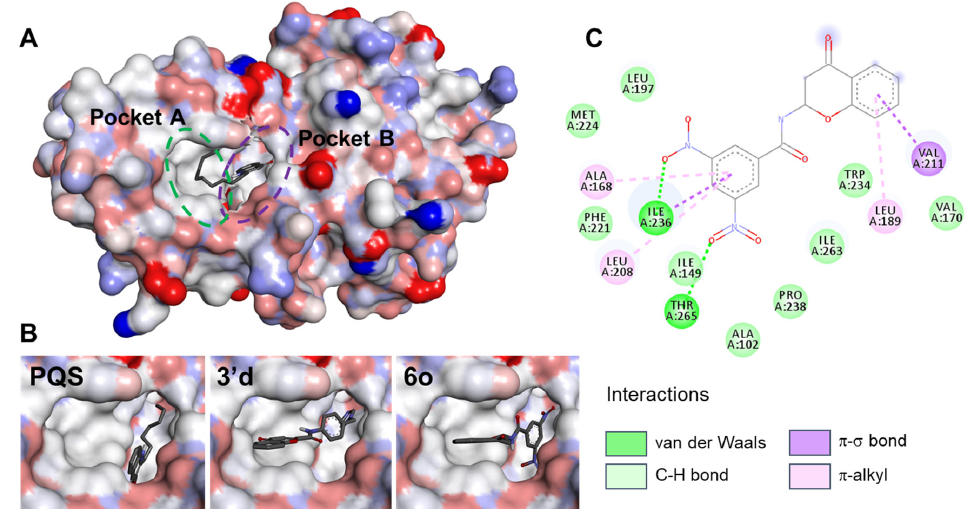
Figure 3. ( A ) PqsR-CBD structure (PDB code 4JVC) binding with NHQ [25]. PqsR solvent surface colored by atom charge (blue = positive charge, red = negative charge). ( B ) PqsR ligand binding site with PQS, compounds 3 ′ d and 6o . ( C ) 2D interactions diagram of compound 3 ′ d . Docking simulations were carried out with the apo form of the PqsR-CBD (PDB code: 4JVC [25]) by keeping all protein residues rigid, except for Ile149, Leu189, Ile236, Tyr258, and Thr265 [25,28]. The docking search space was larger than the A and B pockets of the PqsR-CBD. We considered the binding free energy (E bind , kcal.mol − 1 , Table 1) and inhibition constant (Ki, μ M, Table S1) of the best ranked conformations as the main parameters (score) for the analysis of AutoDock results. Compounds with the highest affinity are those with the lowest binding energy. We also considered the protonated forms at pH = 7.2 for amine-containing structures. Docking results are reported in Tables 2 and 3. Docking of PQS gave a predicted binding energy (E bind ) of − 8.1 kcal.mol − 1 for the best pose, in which PQS is deeply bonded in the B pocket (Figure 3B), through hydrophobic interactions with the residues Ala102, Ile149, Ala168, and Pro238, contrary to NHQ which occupies the two pockets (Figure 3A). As expected, PQS interactions were mainly hydrophobic [25,29,30]. Our docking results showed PQS forms several H-bonds between its carbonyl group and Gln194 and Ser196, and between its 3-hydroxyl group and Leu197.